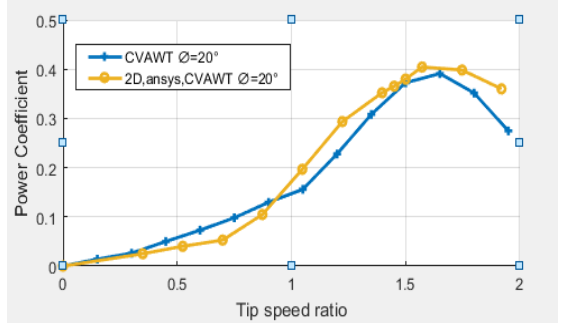
Fig. 9. Pressure distribution along convergent duct inlet angle 12 . °